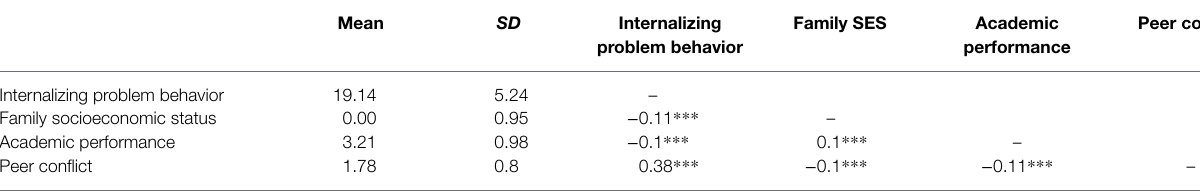
TABLE 2 | Correlation analysis between key variables ( n = 2,467).